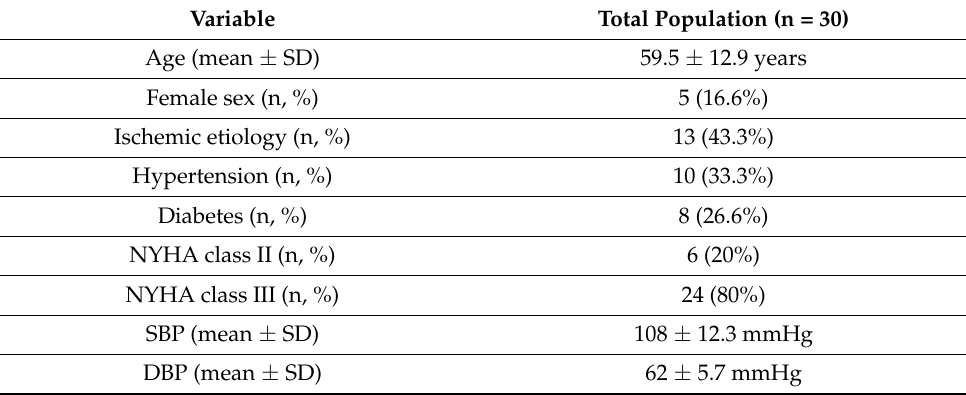
Table 1. Demographic, clinical, and echocardiographic characteristics of the study